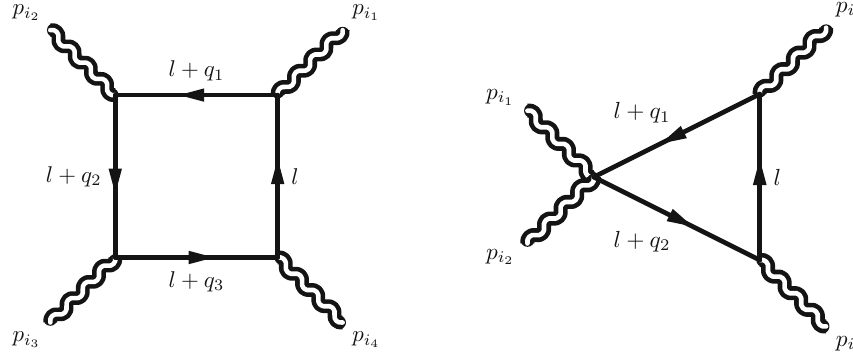
Fig. 4 The square and triangle topologies contributing to the < TTTT > correlation function. All the external momenta are incoming